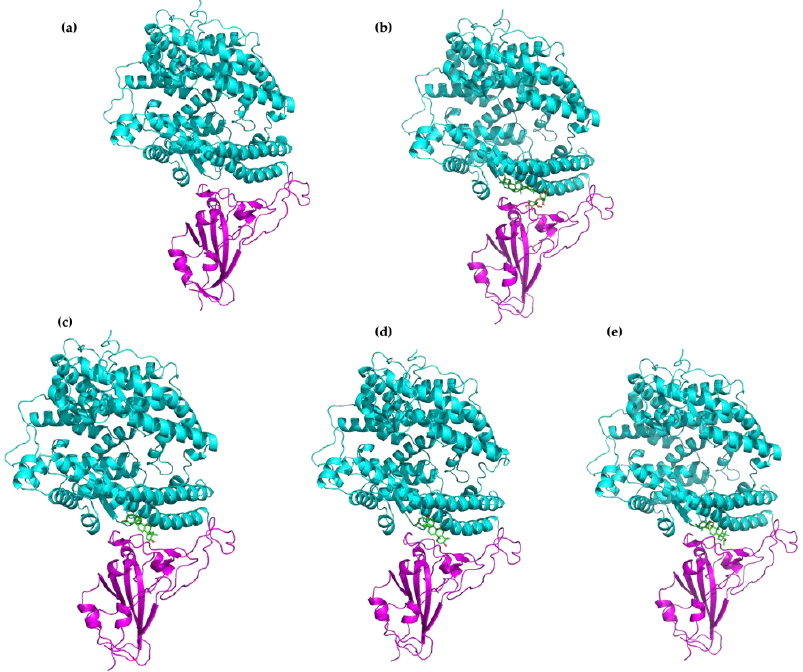
Figure 3. Protein–protein docking poses of the top selected compounds: ( a ) RBD-ACE2 complex, ( b ) RBD-ACE2 GA complex, ( c ) RBD-ACE2 OA5 complex, ( d ) RBD-ACE2 MA4 complex, ( e ) RBD-ACE2 UA2 complex. The RBD subunit is highlighted in magenta color, the ACE2 in cyan color and the ligand is shown in ball-and-stick representation in green color.